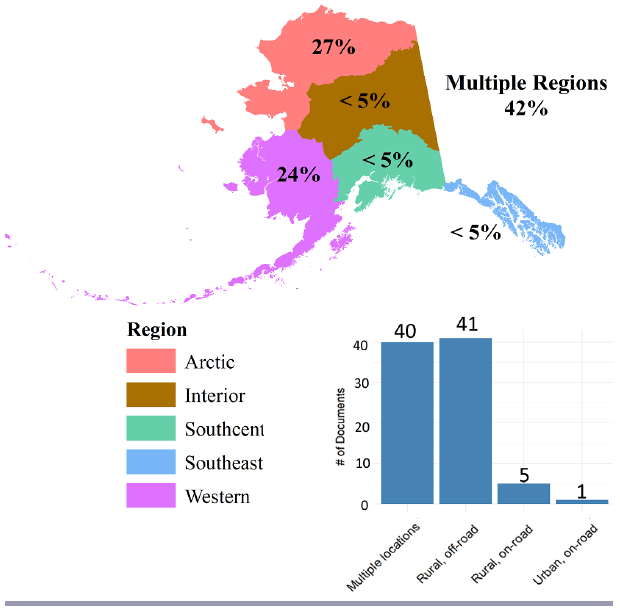
Fig. 2 . Map of five major Alaskan regions, proportion of documents reporting needs for each region, and community- type.